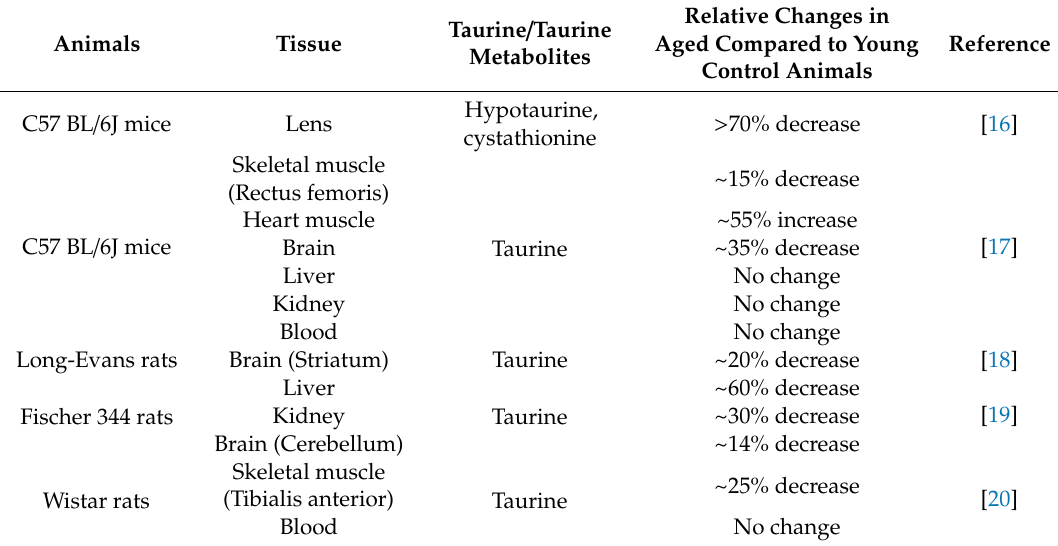
Table 1. Relative changes (%) in tissue taurine / taurine metabolite concentrations in aged compared to young control laboratory rodents.